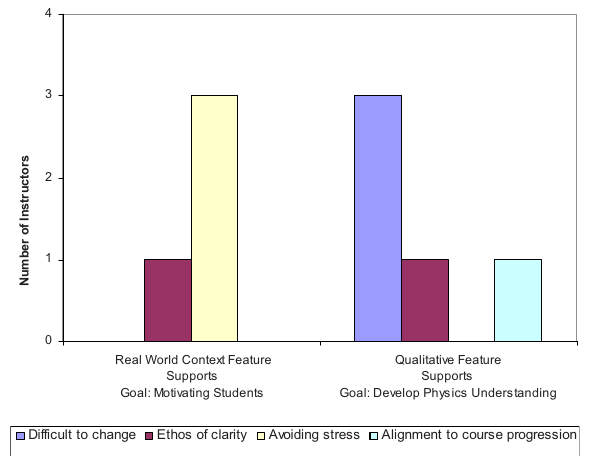
FIG. 11. (cid:1) Color (cid:2) Instructors’ reasons for not using valued prob-